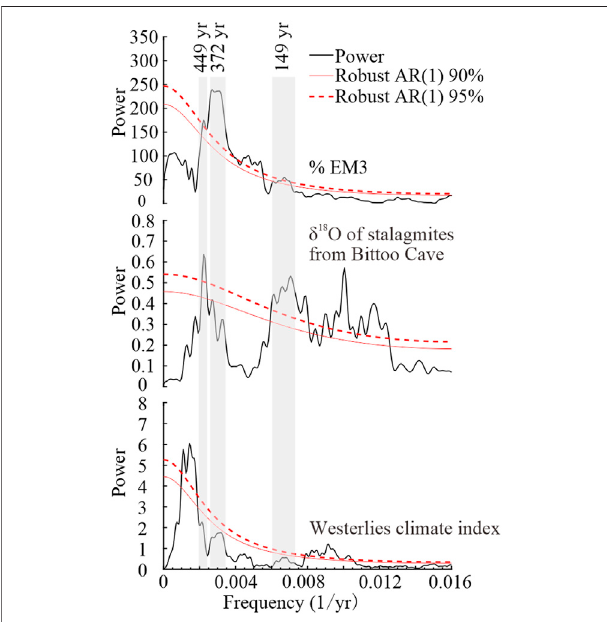
FIGURE10| Spectralresultsofproxyrecords.Fromtoptobottom:EM3 fraction, δ 18 O of stalagmites from the Bittoo Cave (Kathayat et al., 2016), and westerliesclimateindex(Anetal.,2012).Shadedbarsindicatehighlycoherent spectral peaks.